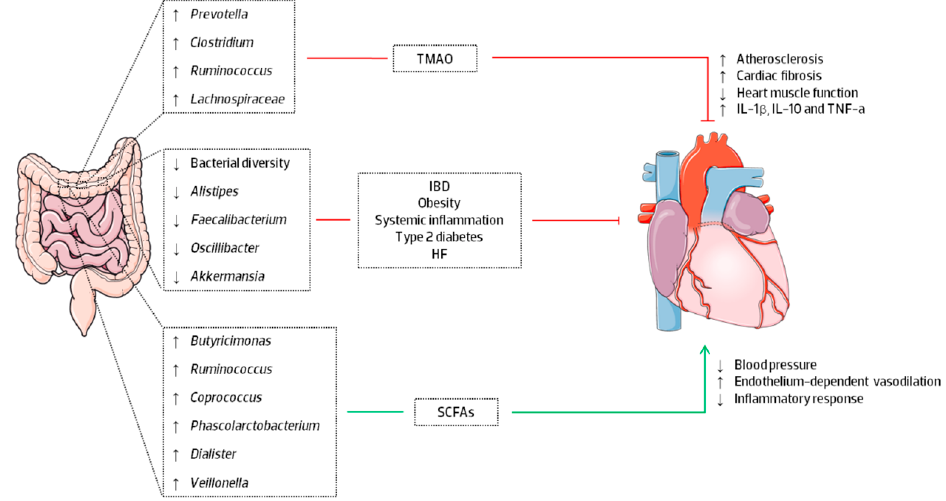
Figure 1. Schematic representation of the influence of gut microbiome (GM) modulation and metabo- lites in the cardiovascular system and in HF (heart failure). TMAO, trimethylamine N-oxide; SCFAs, short-chain fatty acids; IBD, inflammatory bowel disease; IL-1 β , interleukin 1 beta; IL-10, interleukin 10; TNF- α , Tumor Necrosis Factor alfa; ↑ , increased; ↓ , decreased. The figure was produced